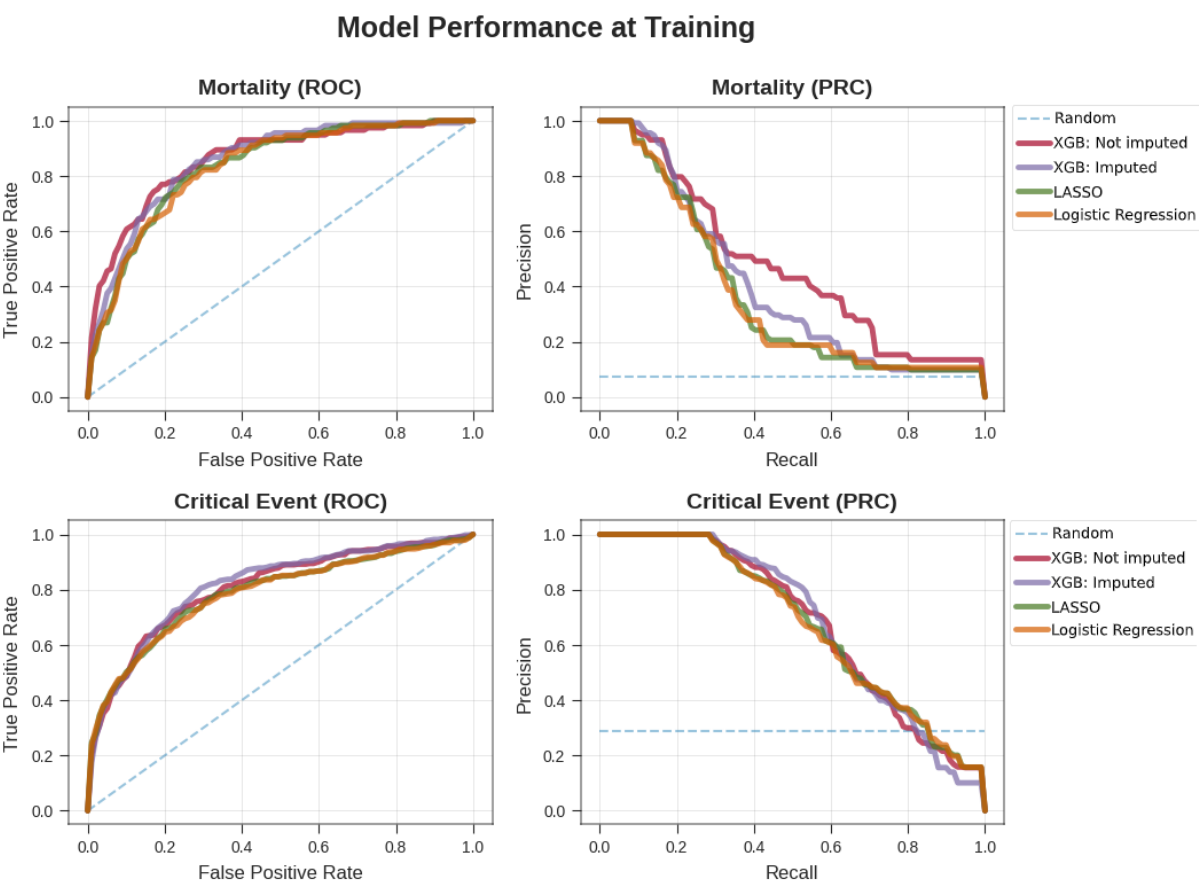
Figure 2. Comparison of the performance of the XGBoost and baseline models. Performance of the XGBoost classifier by ROC curves (left) and PR curves (right) on the unimputed data set (red) for mortality (top) and critical event (bottom) prediction versus the three baseline models: XGBoost classifier on the imputed data set (purple), LASSO (green), and LR (orange). LASSO: least absolute shrinkage and selection operator; PRC: precision-recall curve; ROC: receiver operating characteristic; XGB: Extreme Gradient